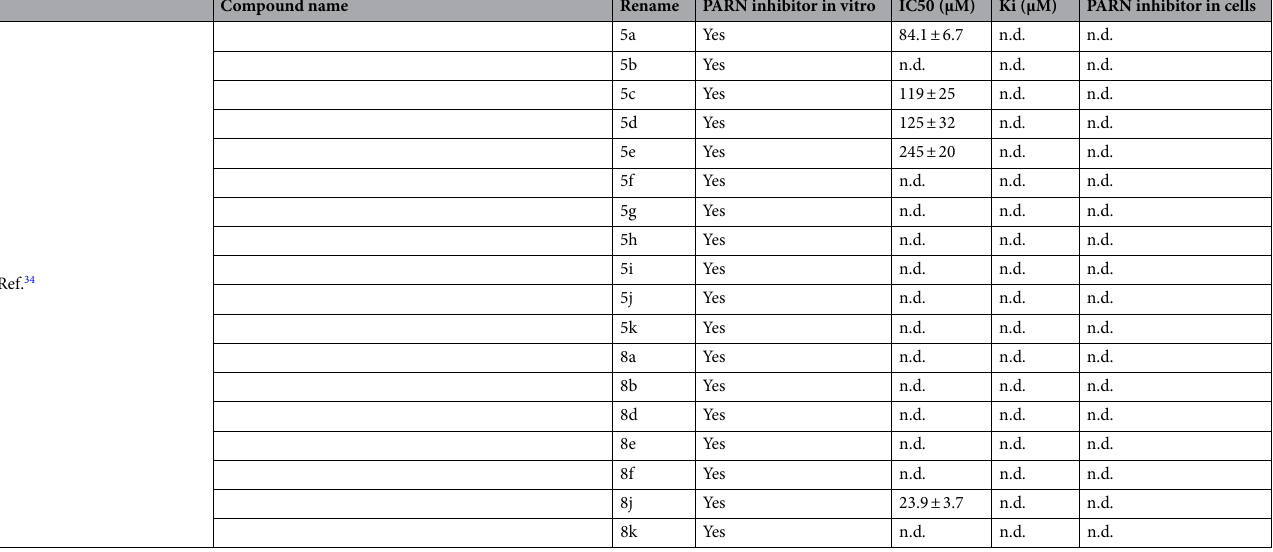
Table 1. List of all the compounds tested as PARN inhibitors with their corresponding properties 30,32–34